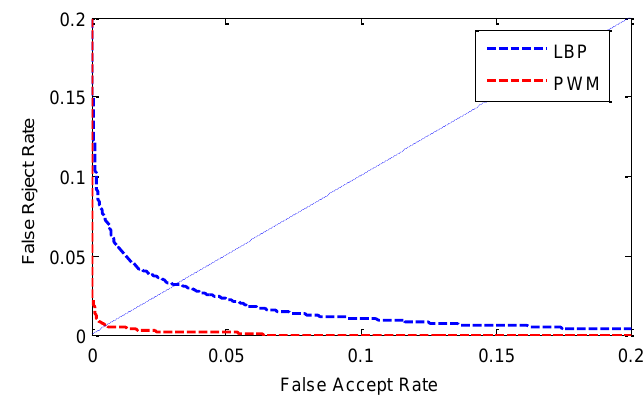
Figure 9. ROC curves by different